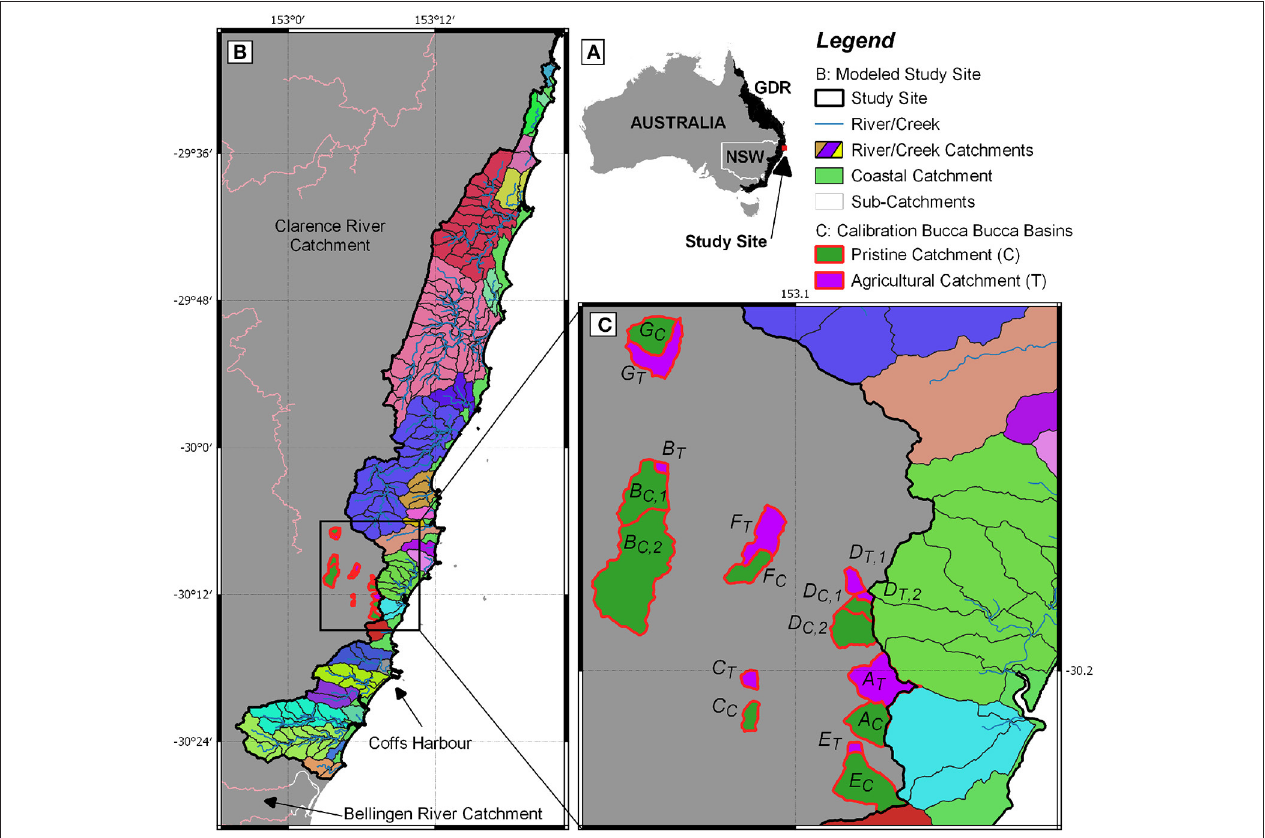
FIGURE 1 | (A) Australia and the Great Dividing Range (GDR) in black with the location of the study site. (B) Study site, comprised of 217 sub-catchments (framed in black), 21 coastal catchments, classified as area between river/creek/coastal lake catchments (indicated in green), and 26 creek, river, and coastal lake catchments (indicated in different colors). The largest city of the study area is Coffs Harbour. (C) A total of 17 sub-catchments within the Bucca Bucca Creek catchment, (framed in red and labeled A–G) where spatial and temporal water quality monitoring, as well as land use and hydrology data was used to calibrate our model. Each agricultural (indicated by T and shown in purple) catchment (blueberry horticulture) was paired with an associated pristine (indicated by C and shown in green) catchment (no horticulture) according to White et al. (2018).